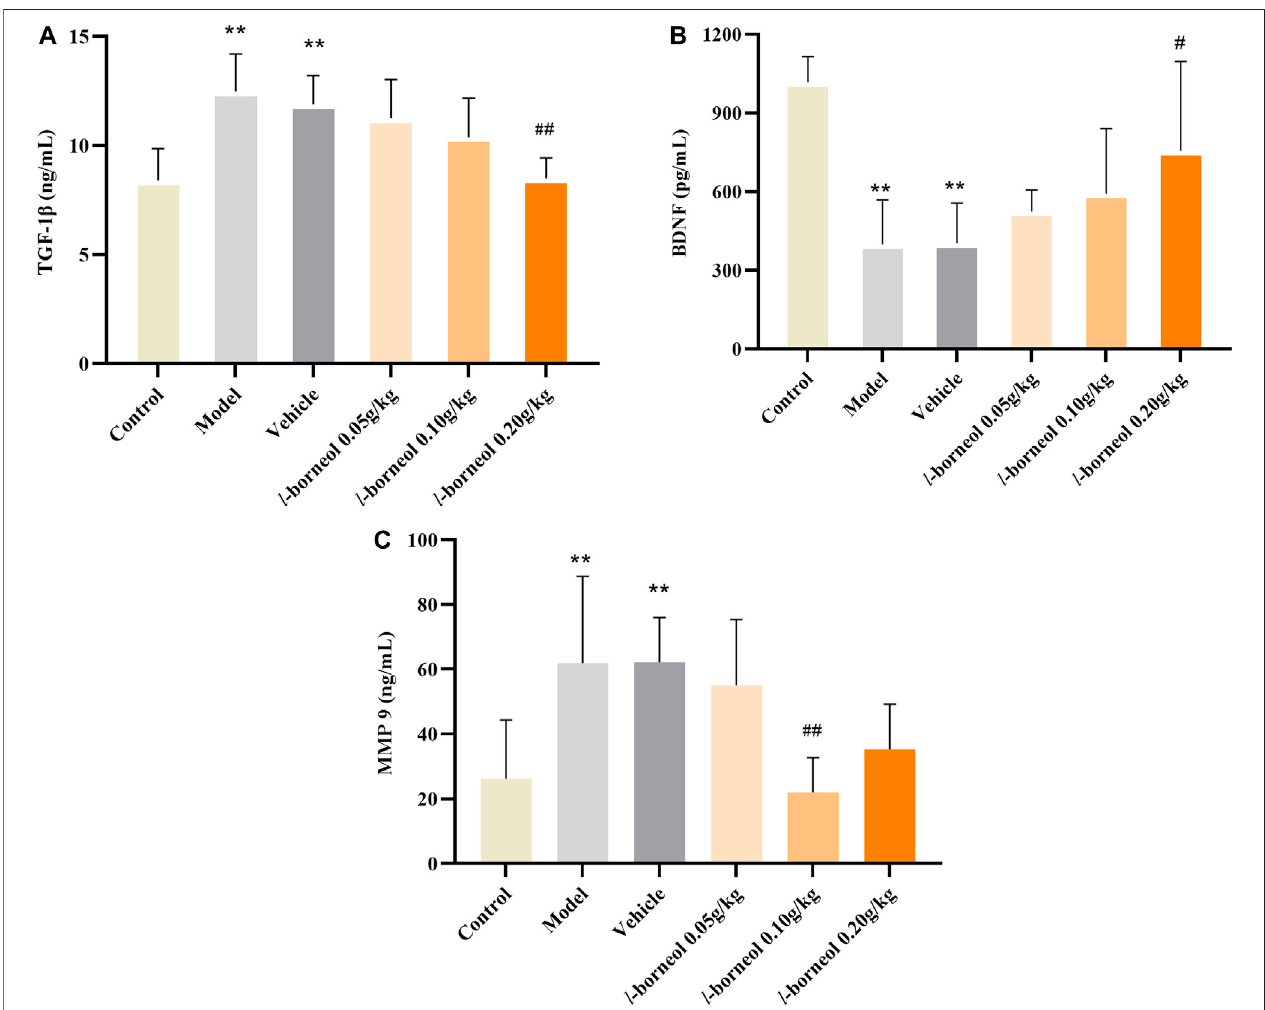
FIGURE 5 | Illustration of TGF- β 1, BDNF, MMP9 in the serum using ELISA ( n (cid:2) 6). ** p < 0.01, compared with the control group; # p < 0.05, ## p < 0.01, compared with the vehicle group.